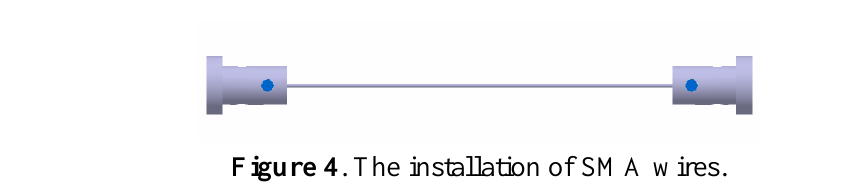
Figure 3 . The prototype of SMA damper.